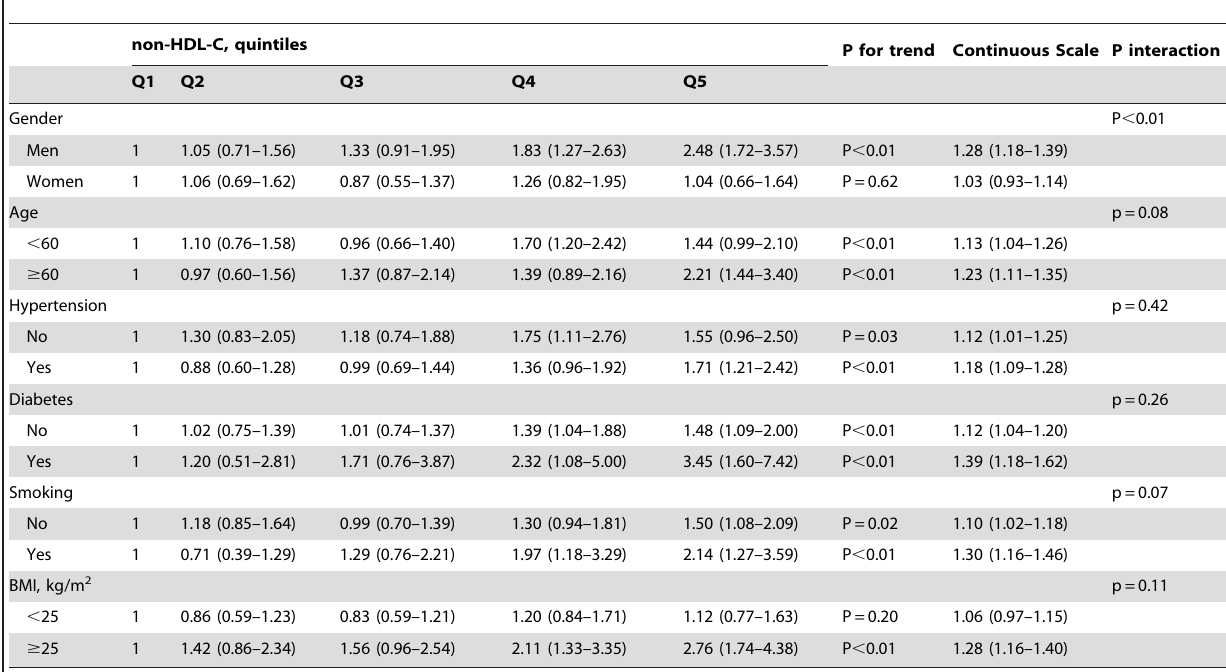
Table 3. Multivariate-adjusted odd ratios * (OR) for ICAS according to non-HDL-C levels, stratified by gender and selected risk